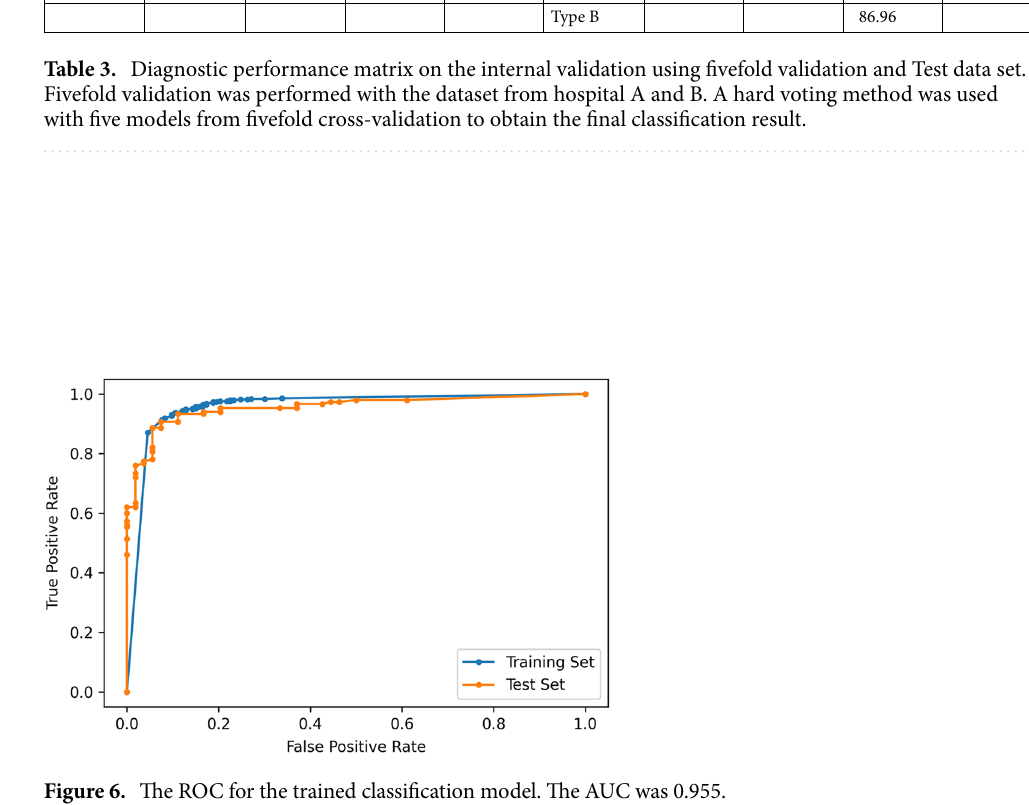
Figure 6. The ROC for the trained classification model. The AUC was